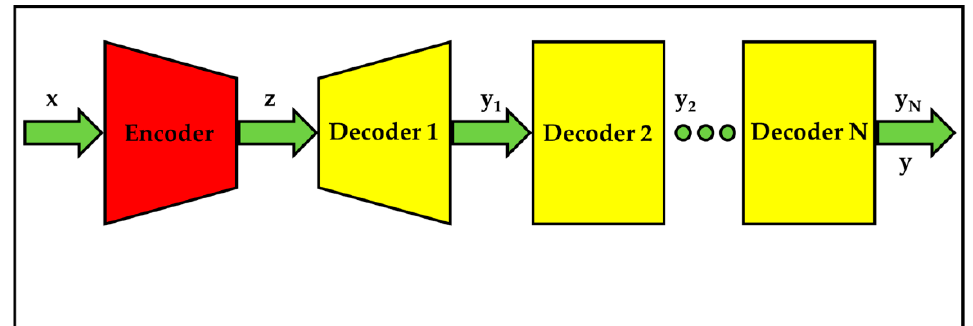
Figure 3. The architecture of cascade decoders-based auto-encoders.